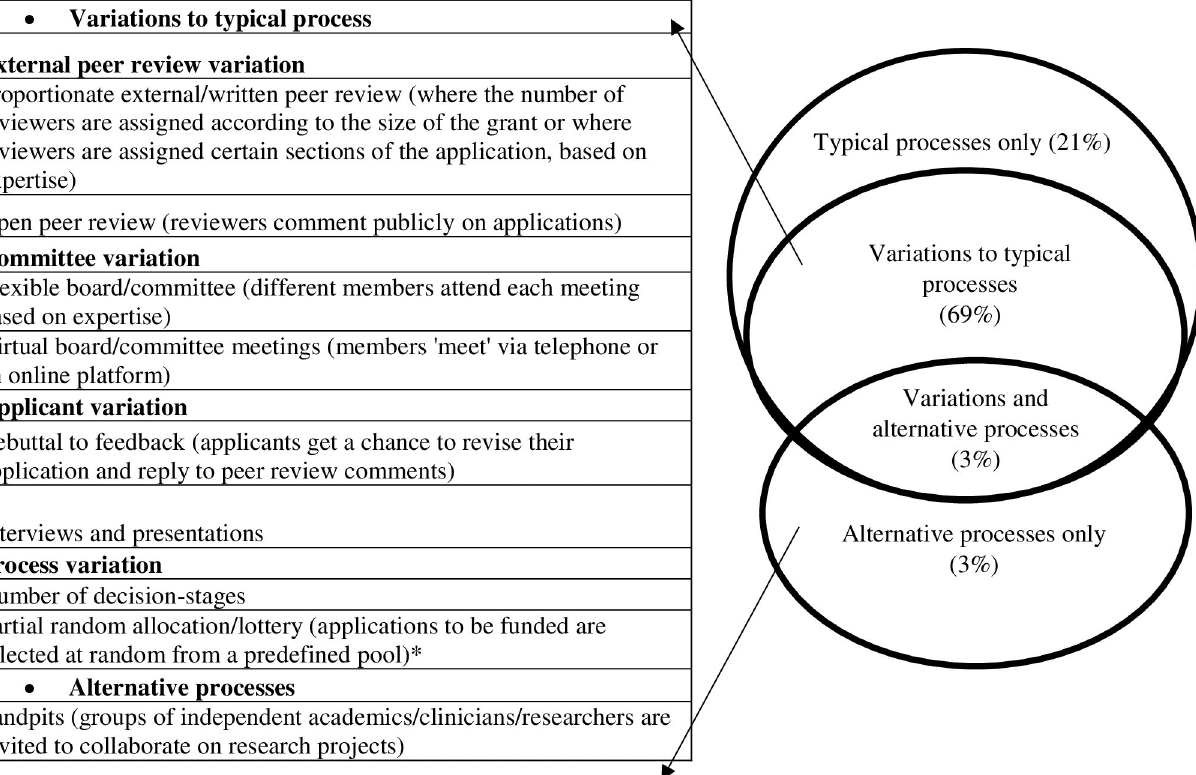
Fig 4. Types of different processes used. Variations to typical processes and approaches that had some uptake from funding organisations and Venn diagram to show percentage of research programmes who use typical, variations to typical and innovative approaches (from total survey sample of = 29). � This process had interest but not uptake (within the survey